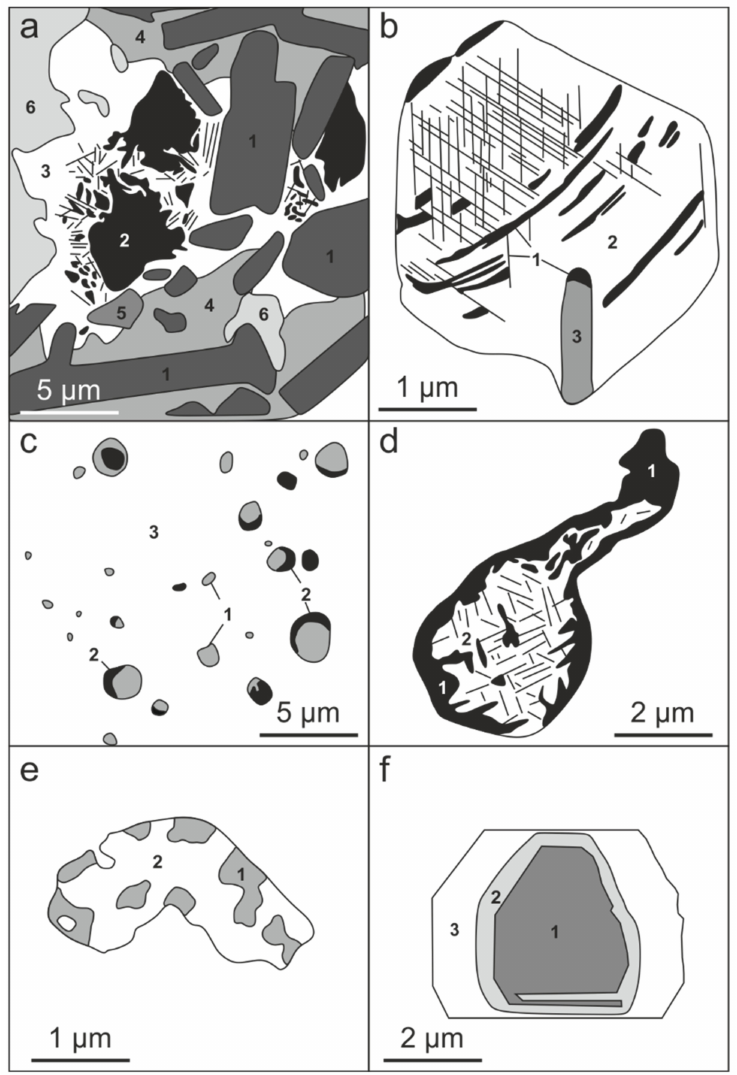
Figure 8. Types of mineral aggregates of the PGM and gold: ( a ) nature of the interrelations of native osmium (1), osmiridium (2), irarsite (Ir,Ru,Rh,Pt)AsS (3), isoferroplatinum Pt 3 Fe (4), erlich- manite OsS 2 and tolovkite IrSbS (5), and silicates (6) in a polymineral aggregate; ( b ) Pt-Ir-Ru alloy isostructural ingrowths (1) in isoferroplatinum (2) containing relic native iridium (3); ( c ) two-phase inclusions of erlichmanite (1) and pyrrhotite (2) in native iridium (3); ( d ) decomposition structures of cuproaurite (1) and gold (2); ( e ) polygonal phases of gold (1) and electrum (2); ( f ) native osmium (Os 98 ) crystal (1) with increasing zones of the mineral with variable composition: Os 54 Ir 39 Ru 5 (2) an Os 67 Ir 33 (3). The figures are based on